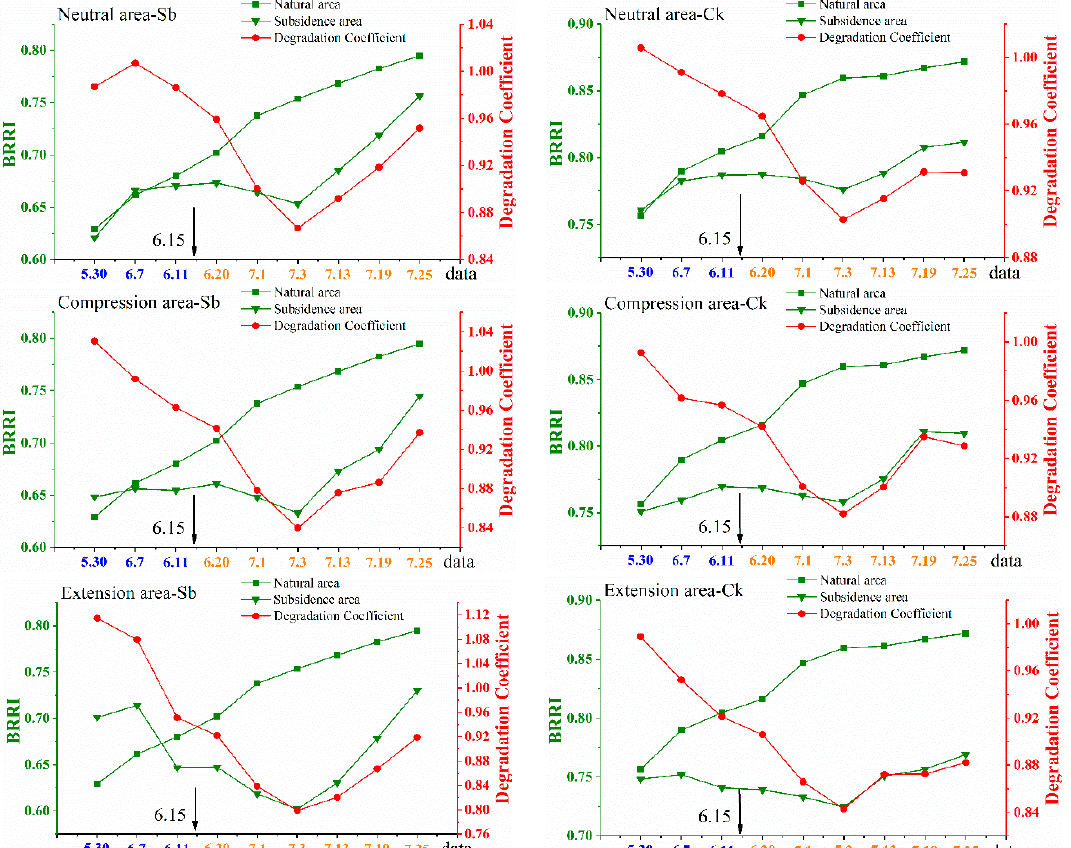
Figure 6. Time series monitoring results of chlorophyll content at canopy scale. All the data in the figures were obtained at transect 1. The 31,115 working faces were mined to the position of transect 1 on 15 June. There were two quadrants in each disturbance area, and only the data from the first quadrat are shown in the figures. Source: Built on the basis of the author’s field survey and calcula-